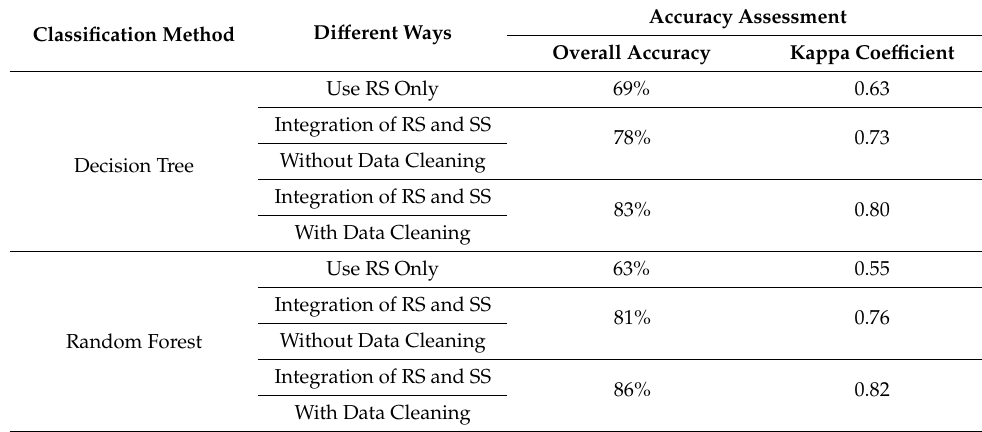
Table 2. Comparison of accuracy